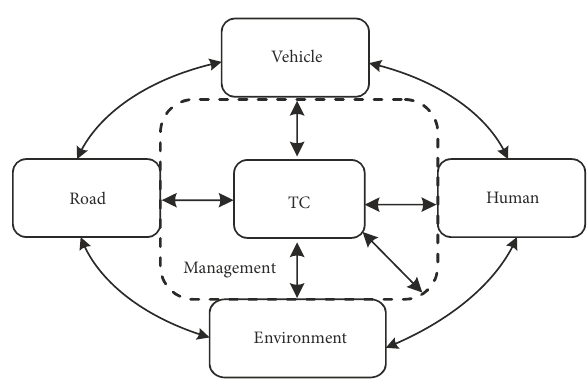
Figure 4. Causal factors